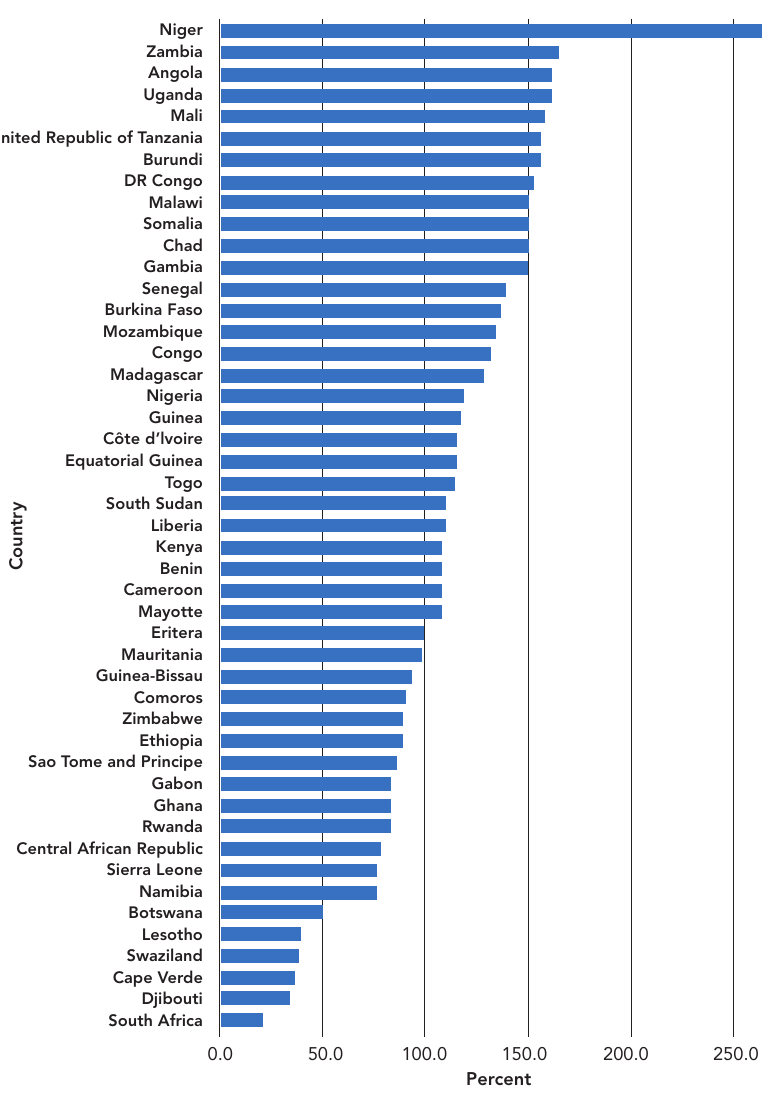
Figure 2: Percent increase in population between 2015 and 2050